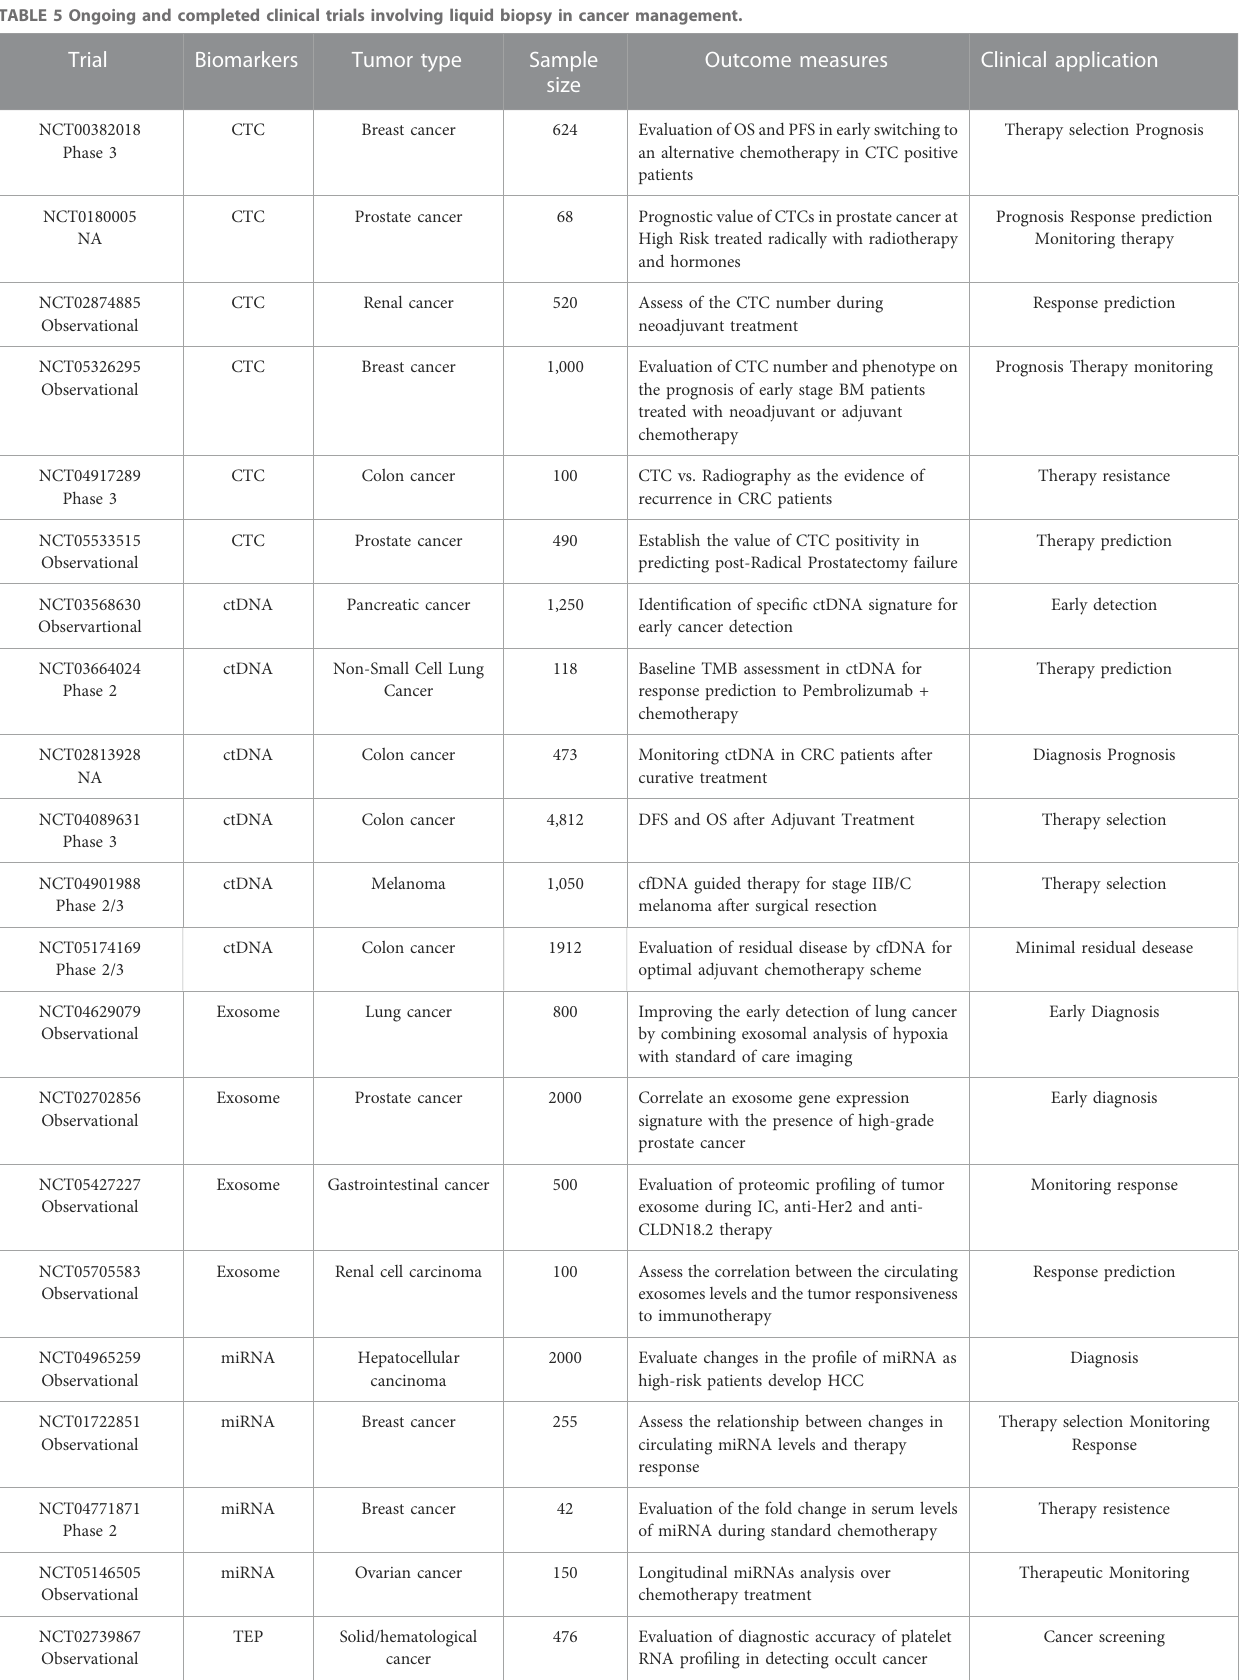
TABLE 5 Ongoing and completed clinical trials involving liquid biopsy in cancer